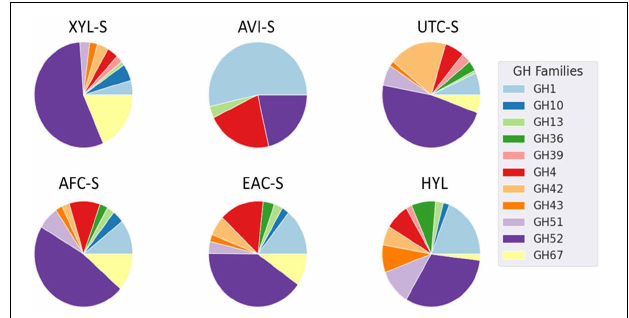
FIGURE 5 | Pie chart of spectral counts from Geobacillus sp. WSUCF1 secretomes grown on different substrates. Only GH enzymes annotation were shown in the figure. Here, each pie chart represents a secretome and the corresponding substrates used are given in the bracket XYL-S (Xylan), AVI-S (Avicel), UTC-S (UT-CS), AFC-S (AFEX-CS), EAC-S (EA-CS) and HYL (Hydrolysate).